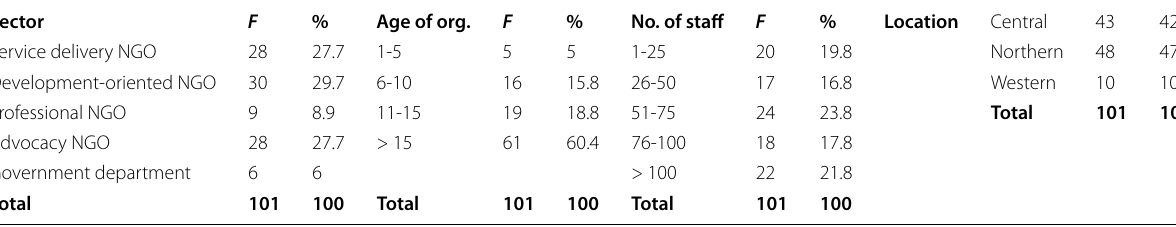
Source : Analysis of quantitative data